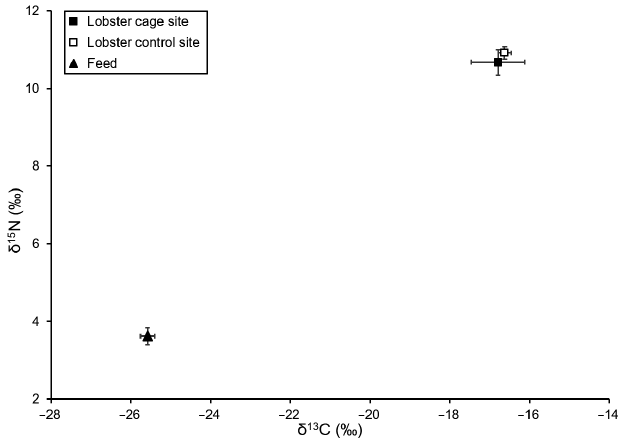
Fig. 5. Biplot of δ 15 N and δ 13 C (mean ± SD) stable isotopes of lobster leg muscle and supplemented feed between cage and control stations at the end of the trial in